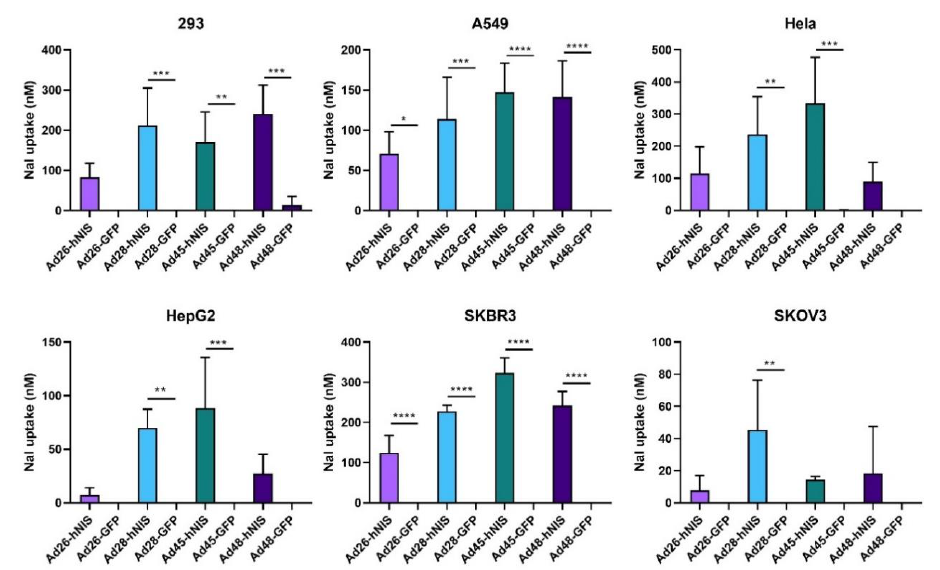
Figure 8. Sodium iodide uptake after infection with the recombinant species D Ad-hNIS viruses. The iodide uptake after infection by the species D Ad-hNIS viruses was evaluated by infecting cell with the indicated viruses at 500 vp / cell and performing a nonradioactive iodide uptake assay after 48 h post infection. NaI uptake after Ad-hNIS infection was compared to NaI uptake after Ad-GFP-Luc infection to control for Ad infection and replication. Data is presented as mean ± standard deviation (SD) from three independent experiments (* p < 0.05, ** p < 0.01, *** p < 0.001, **** p < 0.0001; one-way ANOVA).